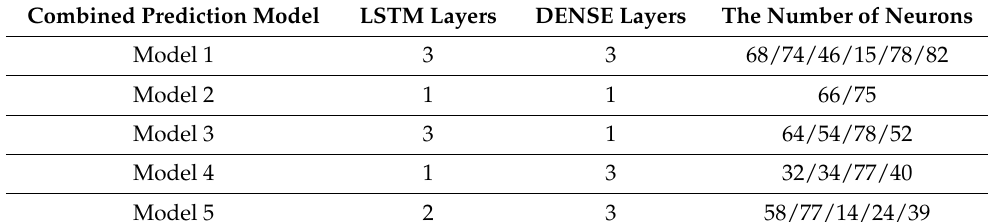
Table 6. Optimal structural parameters of each prediction model in the new data set.